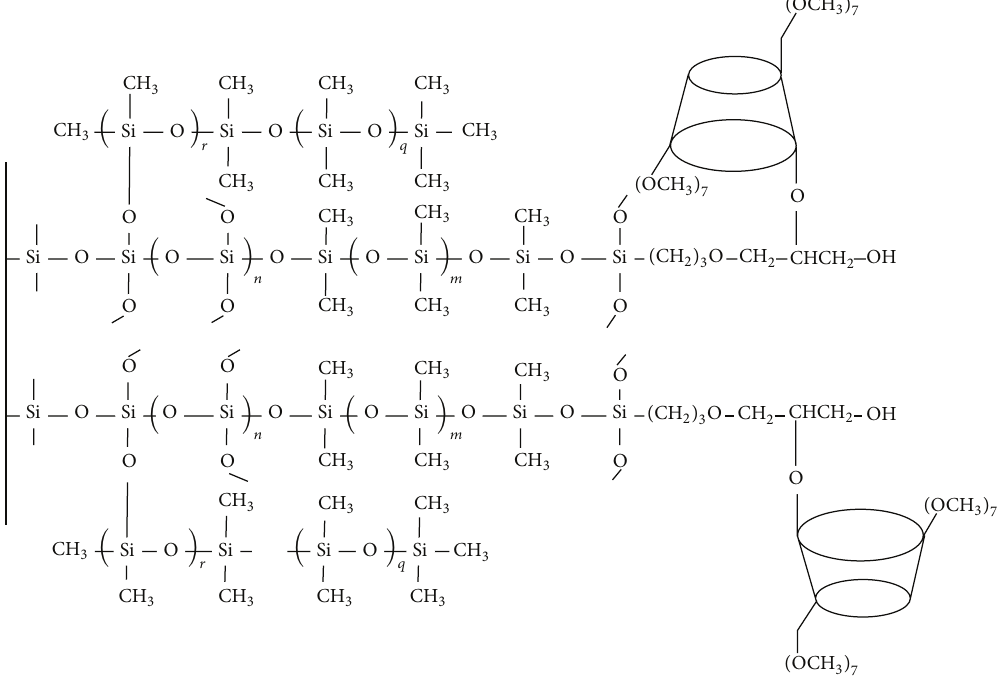
Figure 6: The chemical structure of the DM- 𝛽 -CD/OH-TSO coating [34]. 30 cm